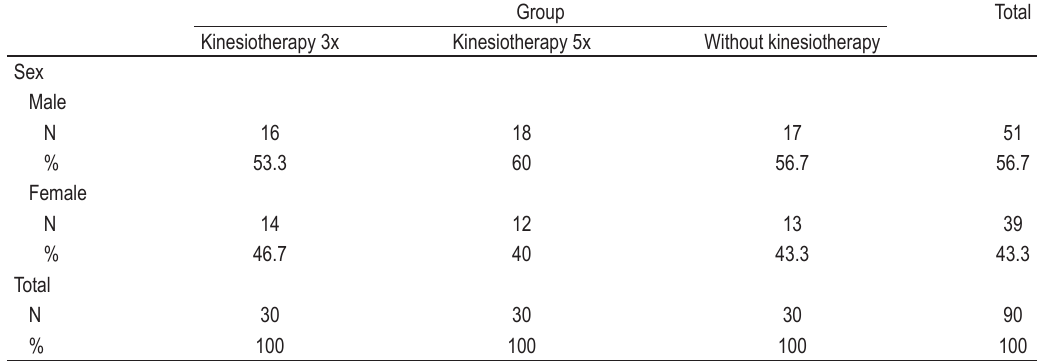
TABLE 2. Comparison of gender distribution in the groups